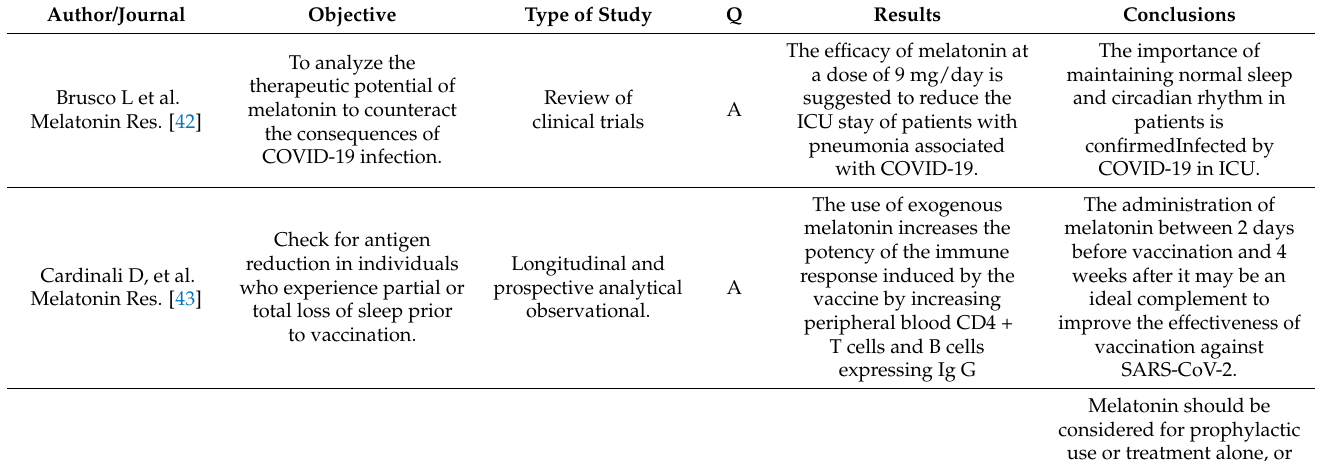
Table 2. Structured summary of each work